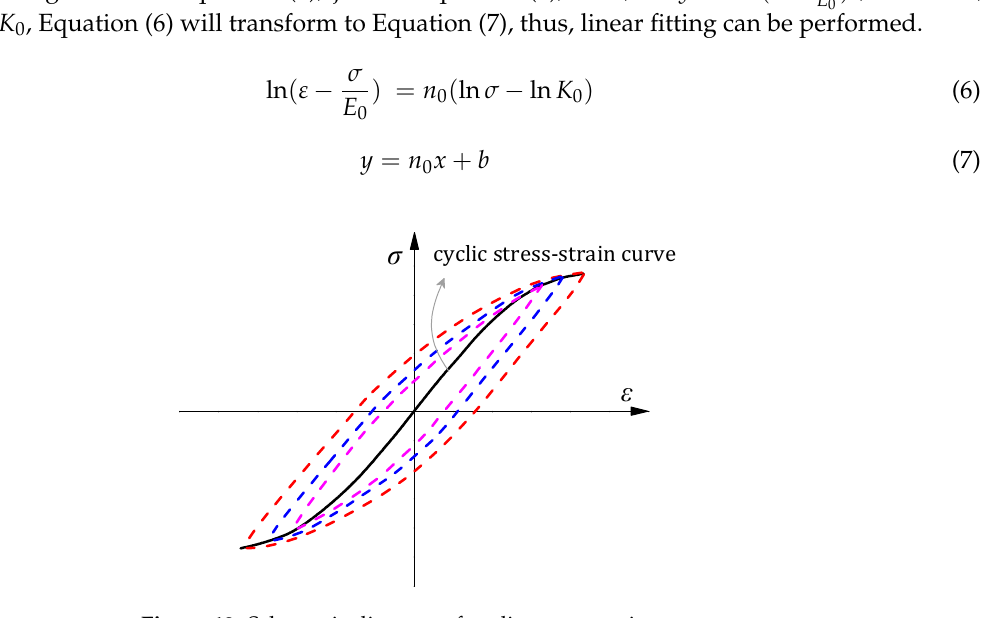
Figure 12. Schematic diagram of cyclic stress-strain curve. Table 5. Parameters of the cyclic stress-strain curves for welding materials. With Q235 Base Metal